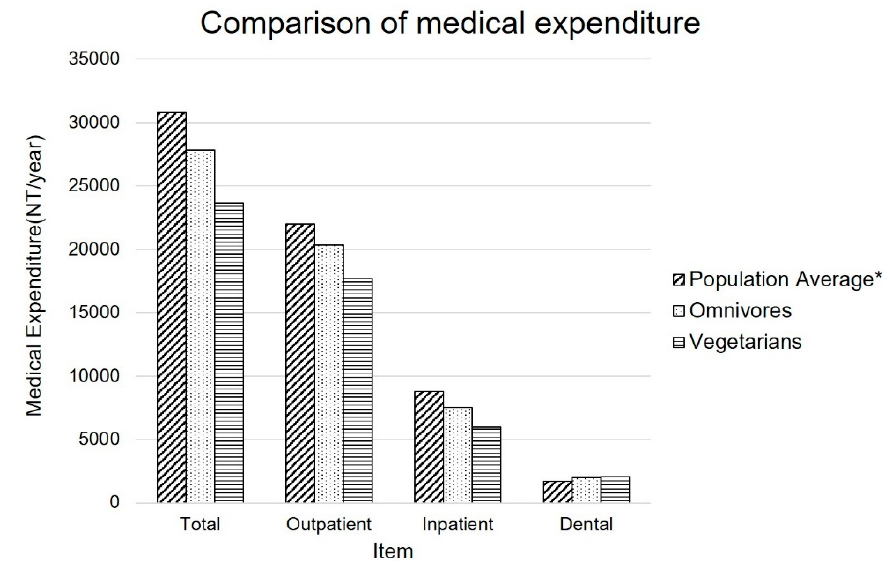
Figure 3. Medical expenditure of vegetarians and omnivores in the Tzu Chi Vegetarian Study, and the age-sex-standardized population average. OPD: Outpatient Department, IPD: Inpatient Department, Dental: Dental Department, * Estimated sex and age-standardized population average.